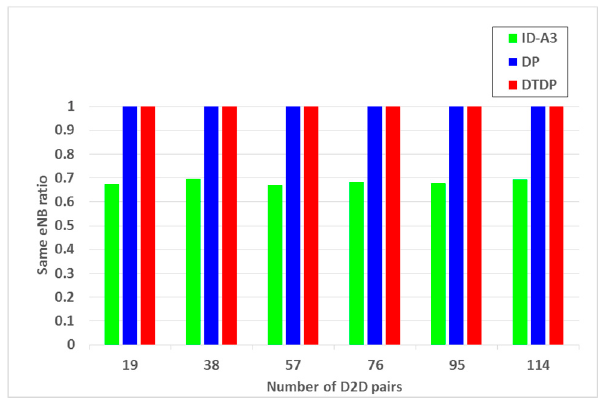
Figure 7. Ratio of D2D pairs having parties connected to the same eNB.